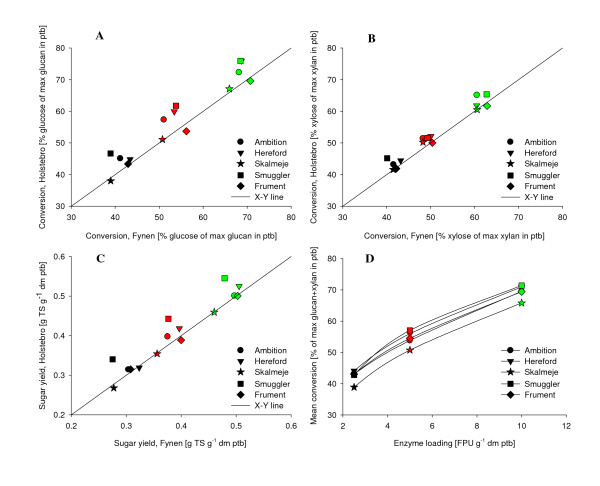
Sugar yield at different enzyme loadings. Sugar yield from hydrolysis of pretreated straw from five cultivars from two sites (Holstebro and Fynen) at varying enzyme loadings (black symbols = 2.5 FPU, red symbols = 5 FPU, green symbols = 10 FPU g-1 dm pretreated straw) presented as (A) glucose conversion as a percentage of maximum glucan in pretreated biomass (ptb), (B) xylose conversion as a percentage of maximum xylan in pretreated biomass, (C) total sugar (TS) yield in gram per gram dm pretreated biomass and (D) average of total sugar convertibility from the two sites as a percentage of maximum glucan and xylan as a function of different enzyme loading.